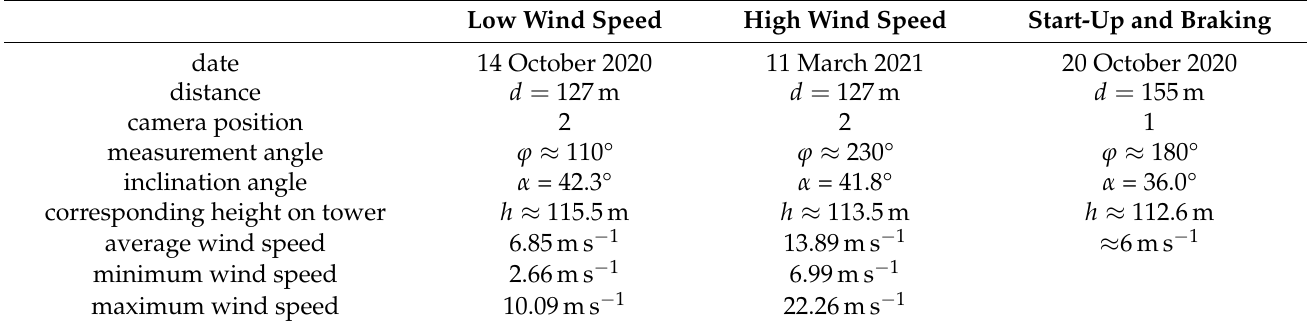
Table 4. Measurement details for different operating conditions. See Figures 1b and 6 for sketches of the experimental